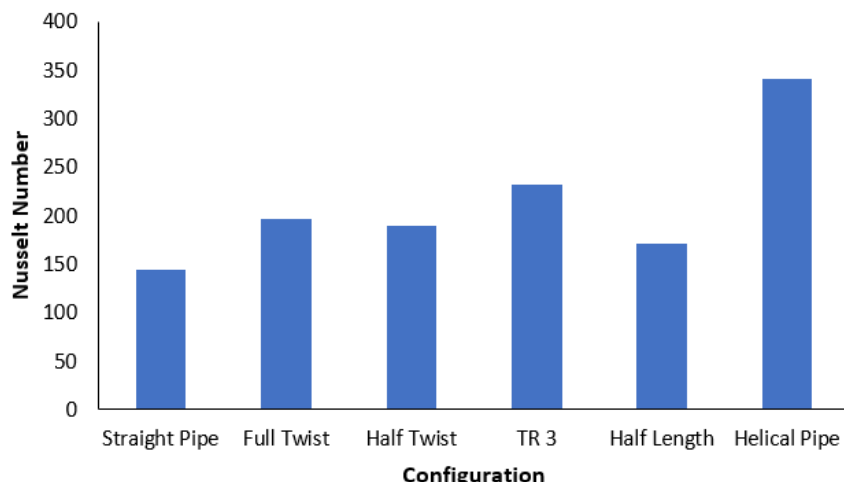
Figure 9. Nusselt numbers of the various configurations.